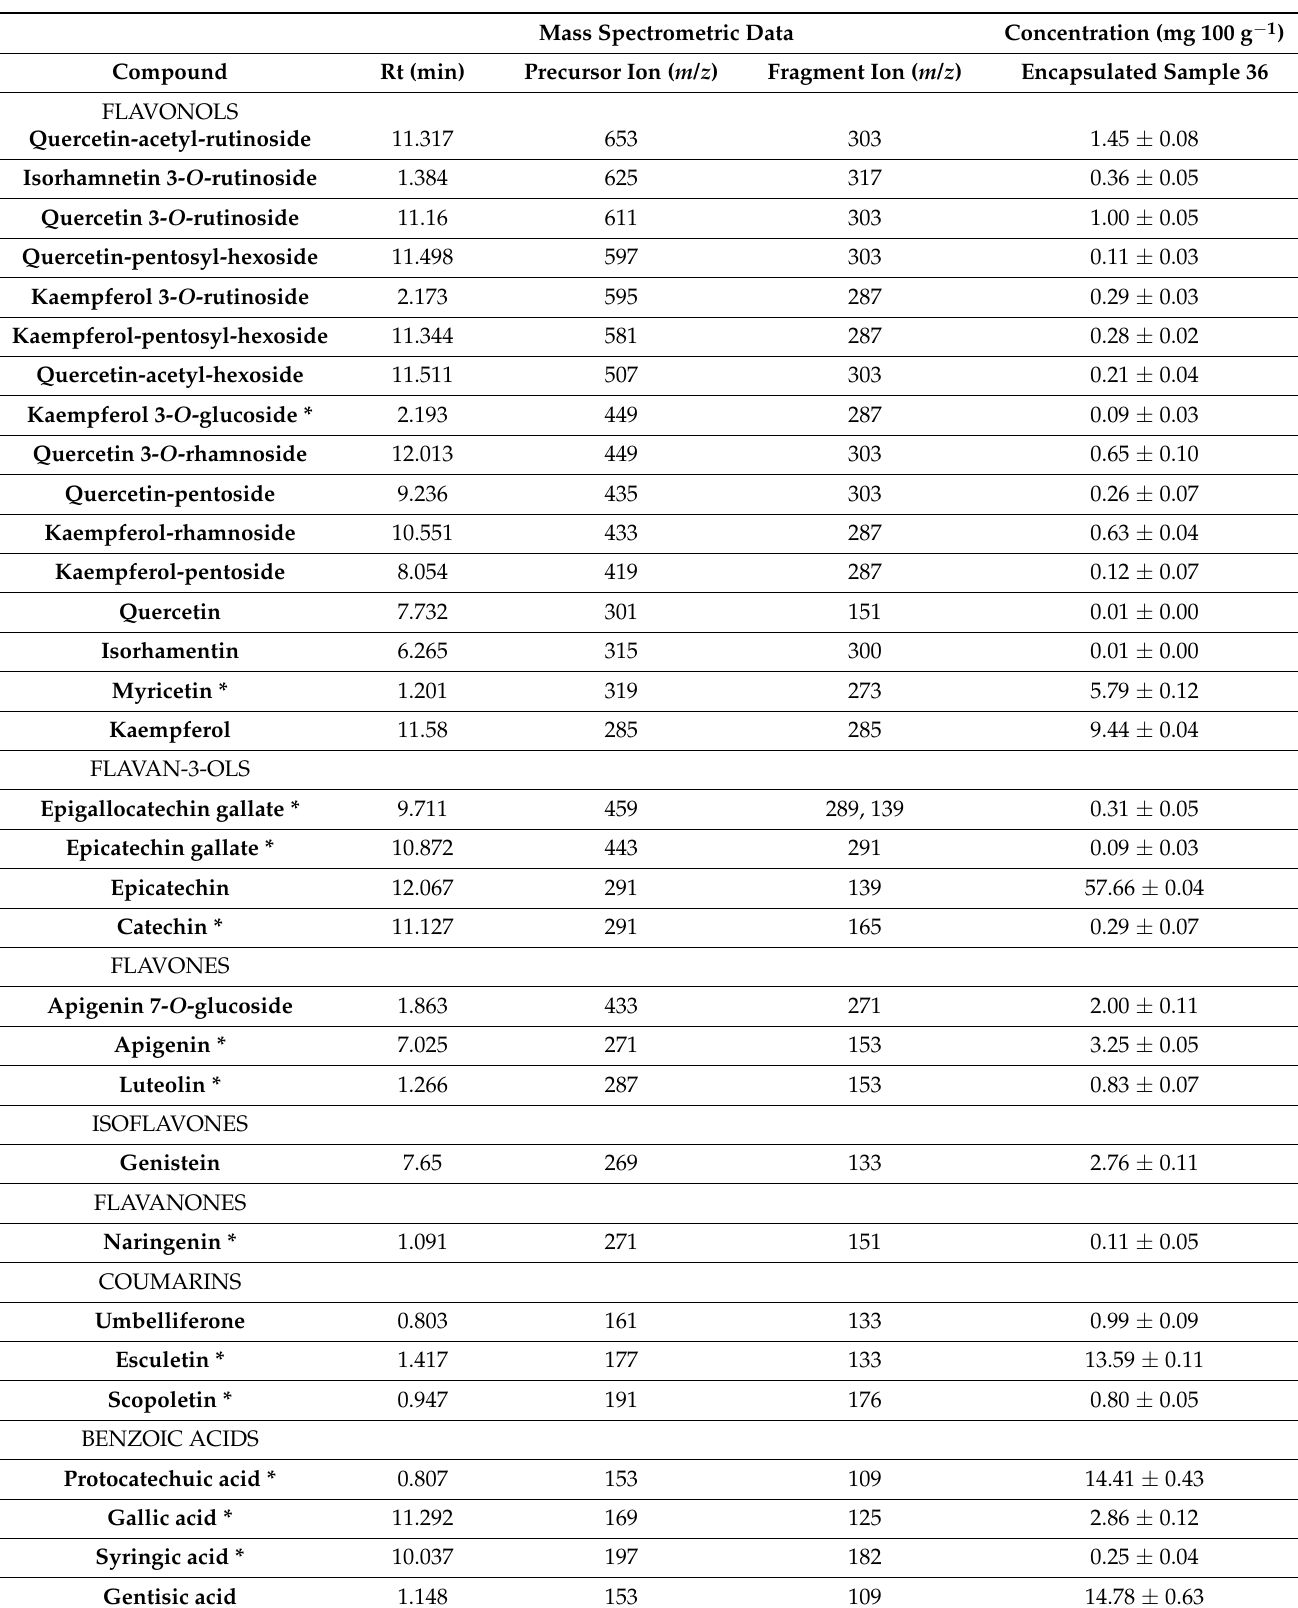
Table 4. Polyphenolic profile including mass spectrometric data and concentration of identified individual compounds of nettle leaves extract powder with the highest encapsulation